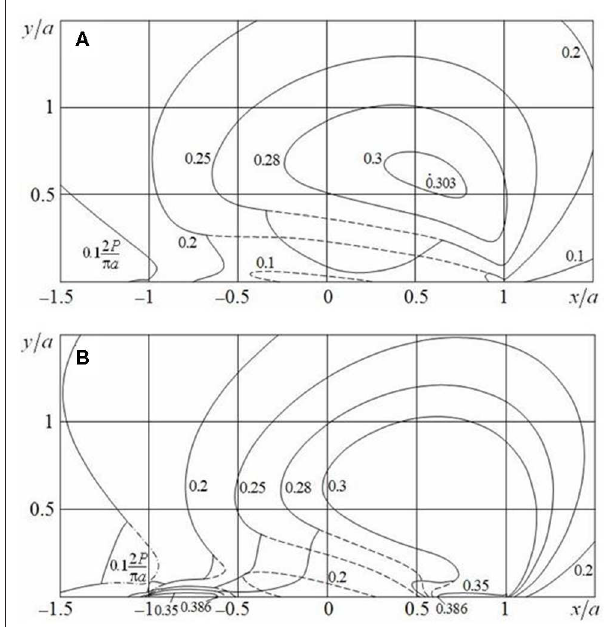
FIGURE 7 | Distribution of maximum tangential stress τ max in the periodic case ( l / a 8) for (A) µ 0 =